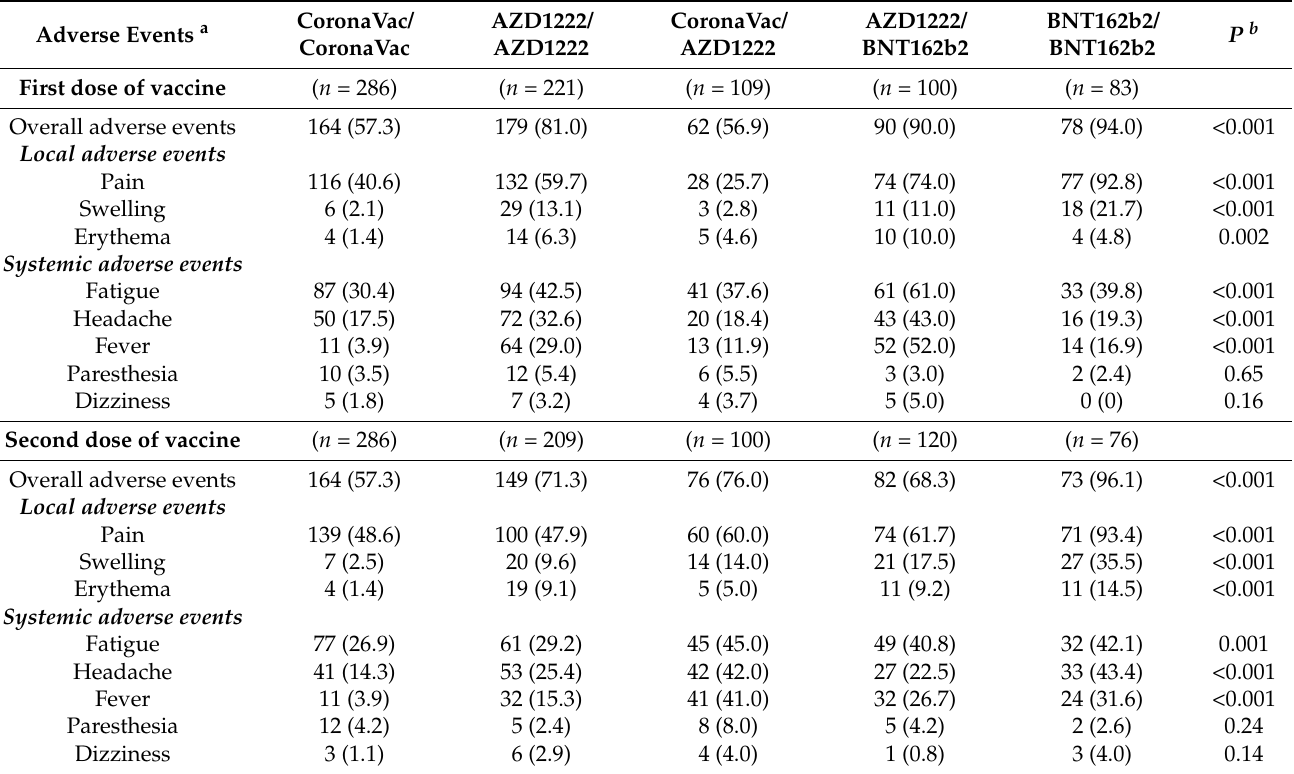
Table 5. The solicited local and systemic adverse events within seven days following a primary series of COVID-19 vaccination, stratified by the COVID-19 vaccine